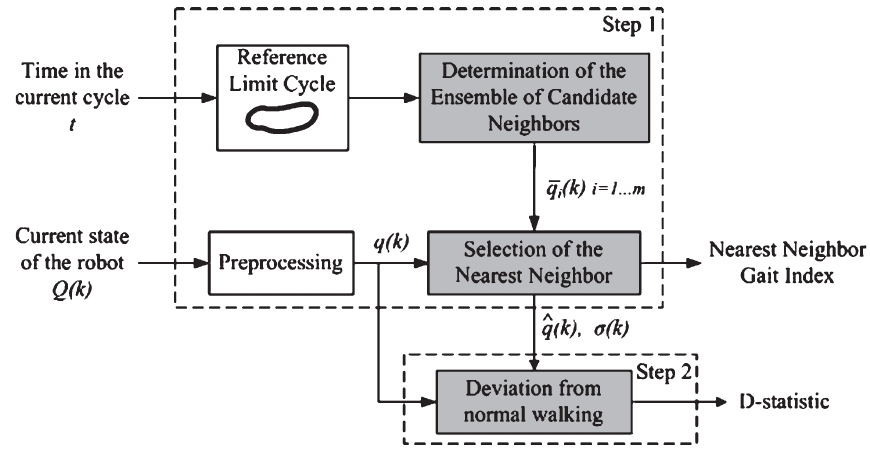
Fig. 1. Block diagram summarizing the proposed method. First, the current state of the walker Q ( k ) is processed to obtain q ( k ). Afterwards, based on timing information, an Ensemble of Candidate Neighbors (ECN) is selected. The ECN is a subset of the Reference Limit Cycle that represents the normal walking of the robot. Next, a Nearest Neighbor search to find the state in the ECN that matches best the current state of the robot, ˆ q ( k ), is performed. Finally, the deviation between the expected and current state of the walker is calculated, the D-statistic. This constitutes, together with the NNGI, the output of the